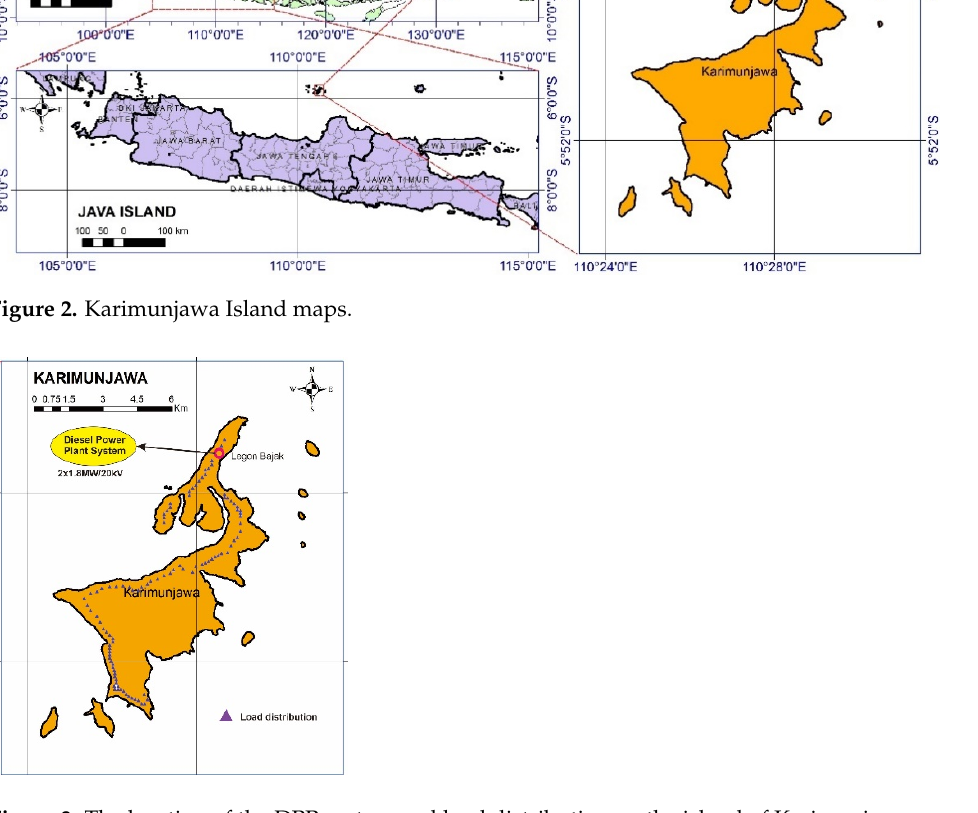
Figure 3. The location of the DPP system and load distribution on the island of Karimunjawa.